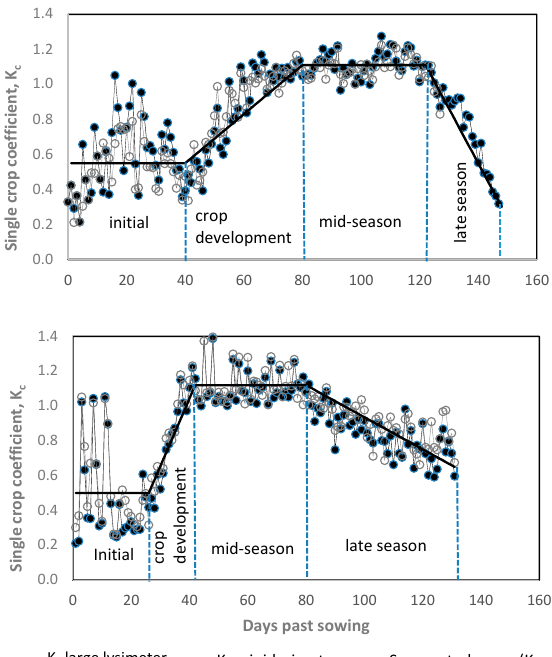
Figure 7. Daily single crop coefficient (K c ) data for barley (top graph) and potato (bottom graph) calculated as the ratio of ET c from each lysimeter and the grass ET o computed with the FAO56 PM-ET o equation. The typical FAO56 segmented crop coefficient curve, with the identification of the four general growth stages, is adjusted (K c obs ).